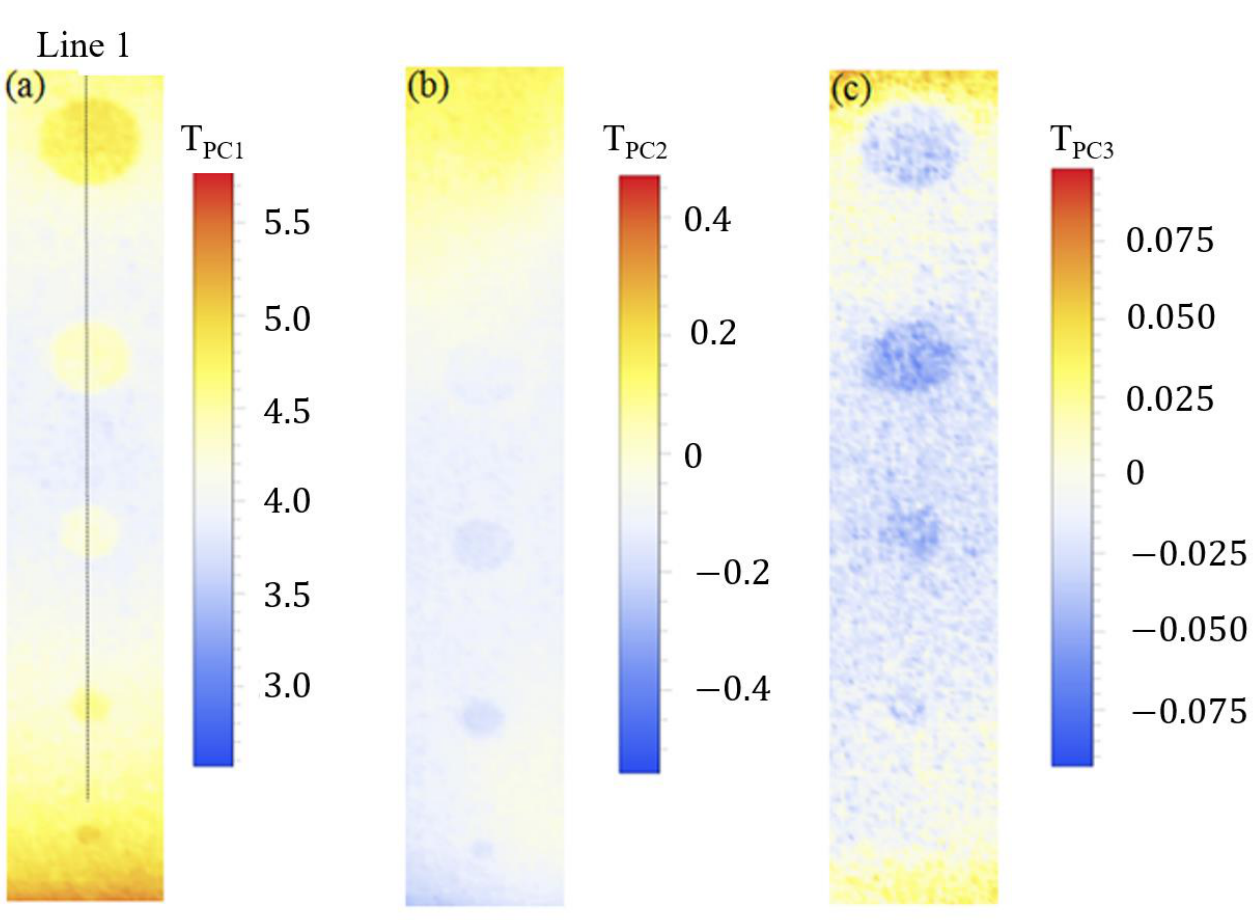
Figure 4. Reconstructed images by PCA algorithm of the sample 1: ( a ) PC1; ( b ) PC2; ( c ) PC3. Line 1 across the center of all flaws.